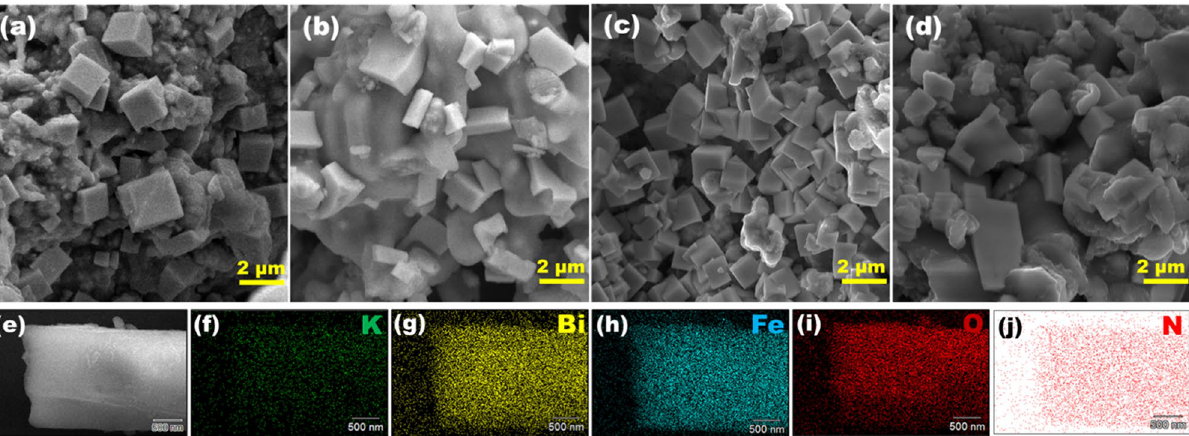
Figure 2. SEM images corresponding to ( a ) KBFO ( b ) 10N-KBFO ( c ) 20N-KBFO ( d ) 30N-KBFO. ( e – j ) EDS mapping images of 20N-KBFO sample showing uniform distribution of K, Bi, Fe, O and N